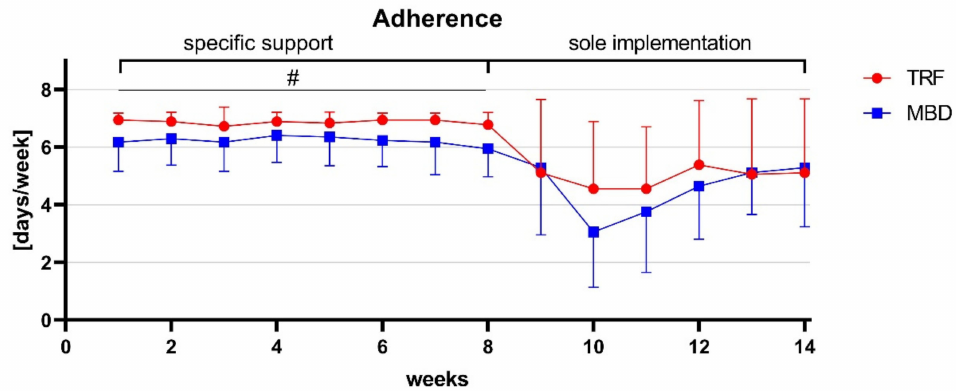
Figure 4. Adherence of the TRF and MBD groups over 14 weeks. Week 1–8: both groups with specific support. Week 9–14: without specific support. Significant group differences were set with p < 0.05 and marked with